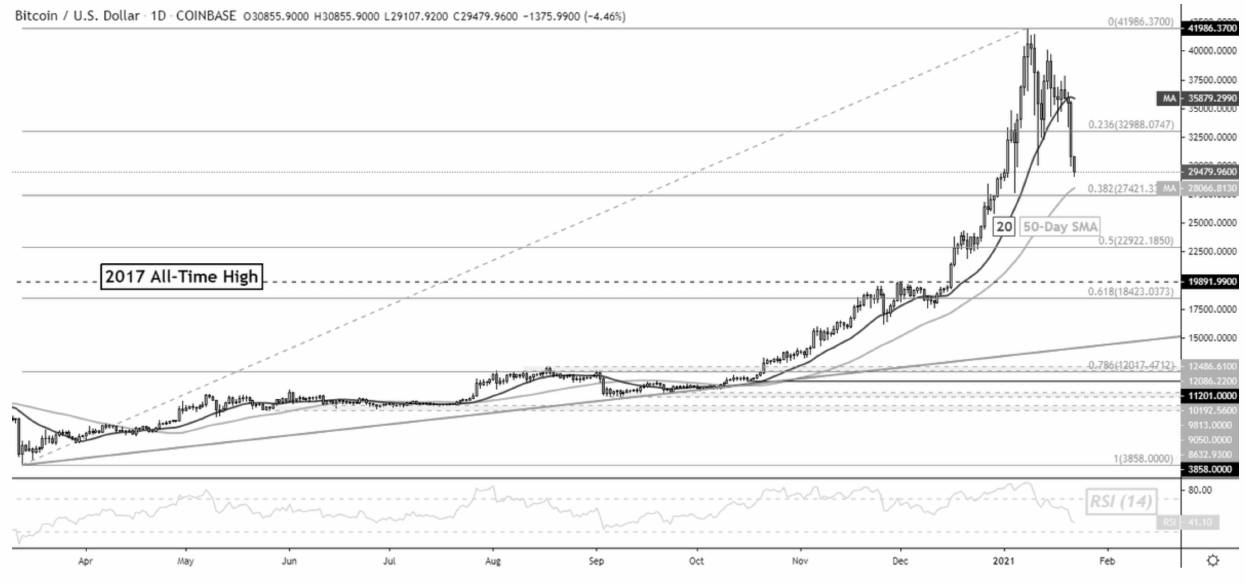
Figure 1. Bitcoin price value from April 2020 to February 2021. Source: Adapted from DailyFX